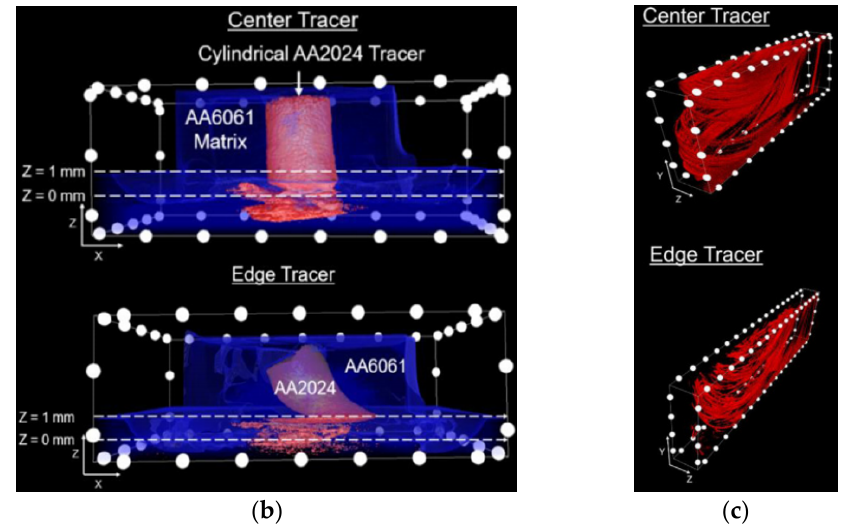
Figure 6. The tracing plastic deformation path method. ( a ) Schematic of tracer. ( b ) X-ray tomography after initial feeding. ( c ) Steady-state deposition.